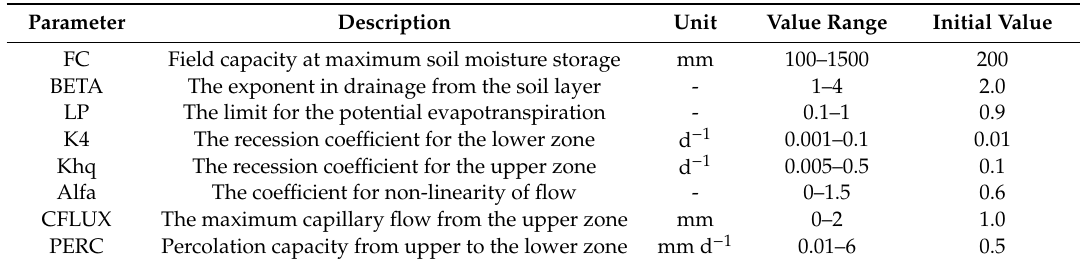
Table 2. Hydrologiska Byråns Vattenbalansavdelning (HBV) model calibrated parameters and their